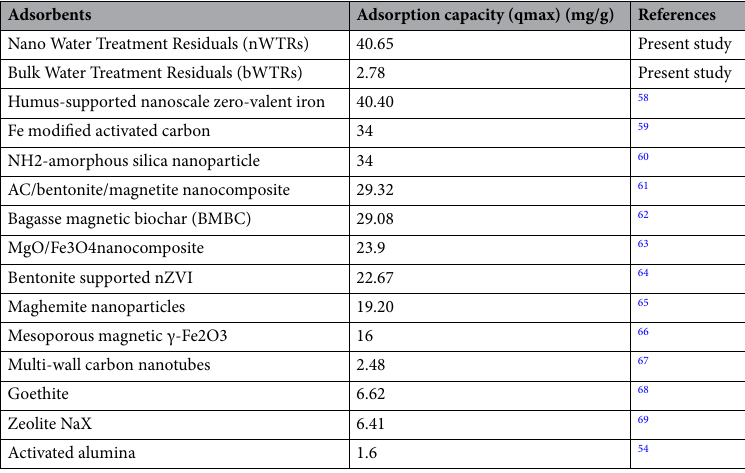
Table 3. Maximum adsorption capacities (qm) of Cr(VI) adsorption on nWTRs and the other adsorbents documented in the literature.